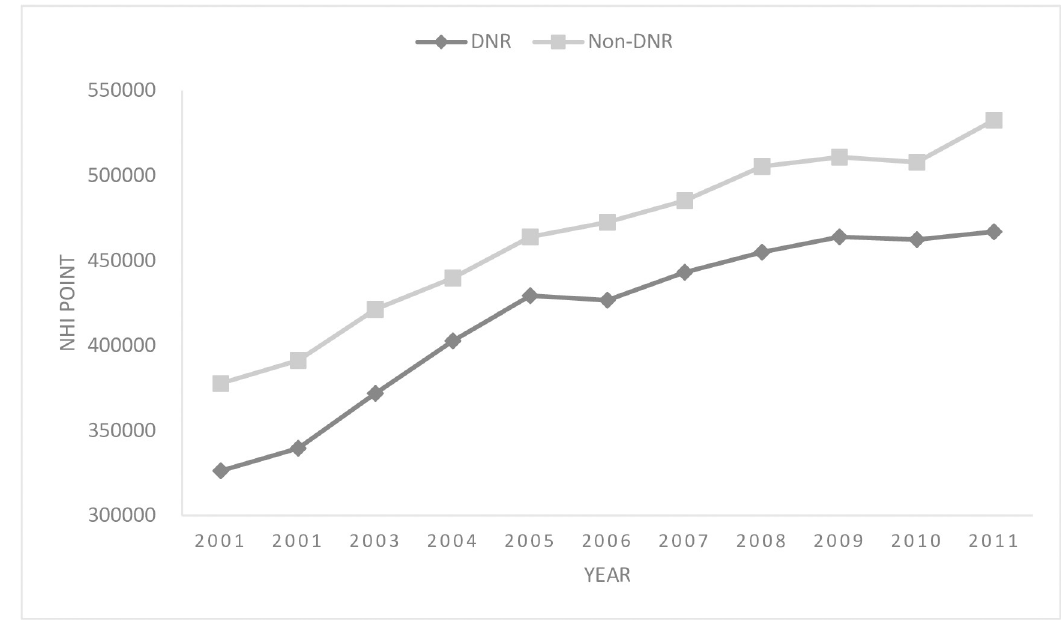
Fig 5. Average National Health Insurance (NHI) spending on do-not-resuscitate (DNR) and Non-DNR cases in Taiwan.